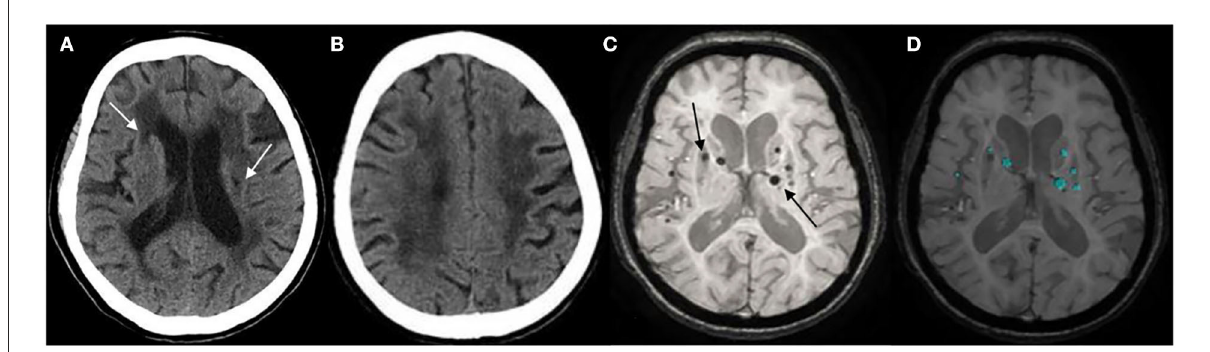
FIGURE3 (A) Lacunar infarcts (LIs) are seen in the bilateral basal ganglia on computed tomography (CT) (arrow). (B) Extensive hypodensity in the bilateral corona radiate, and the Blennow score of the LA was 3. (C) susceptibility-weighted imaging (SWI) shows multiple cerebral microbleeds (CMBs; > 5) in a 73-years-old female with hypertension for 20 years (arrow). (D) CMBs diagnosed by BioMind AI software on SWI (green marker).